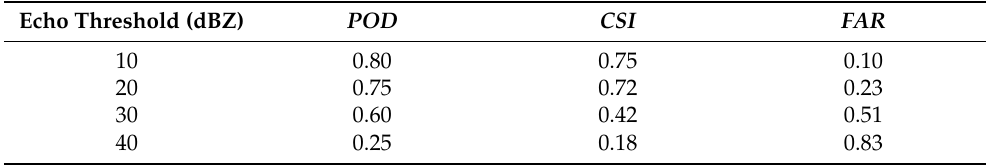
Table 8. Deep learning algorithm extrapolation results at 1 h.